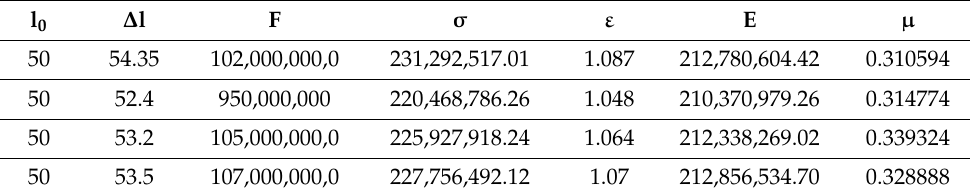
Table 1. Measured and calculated mechanical properties of the specimen.